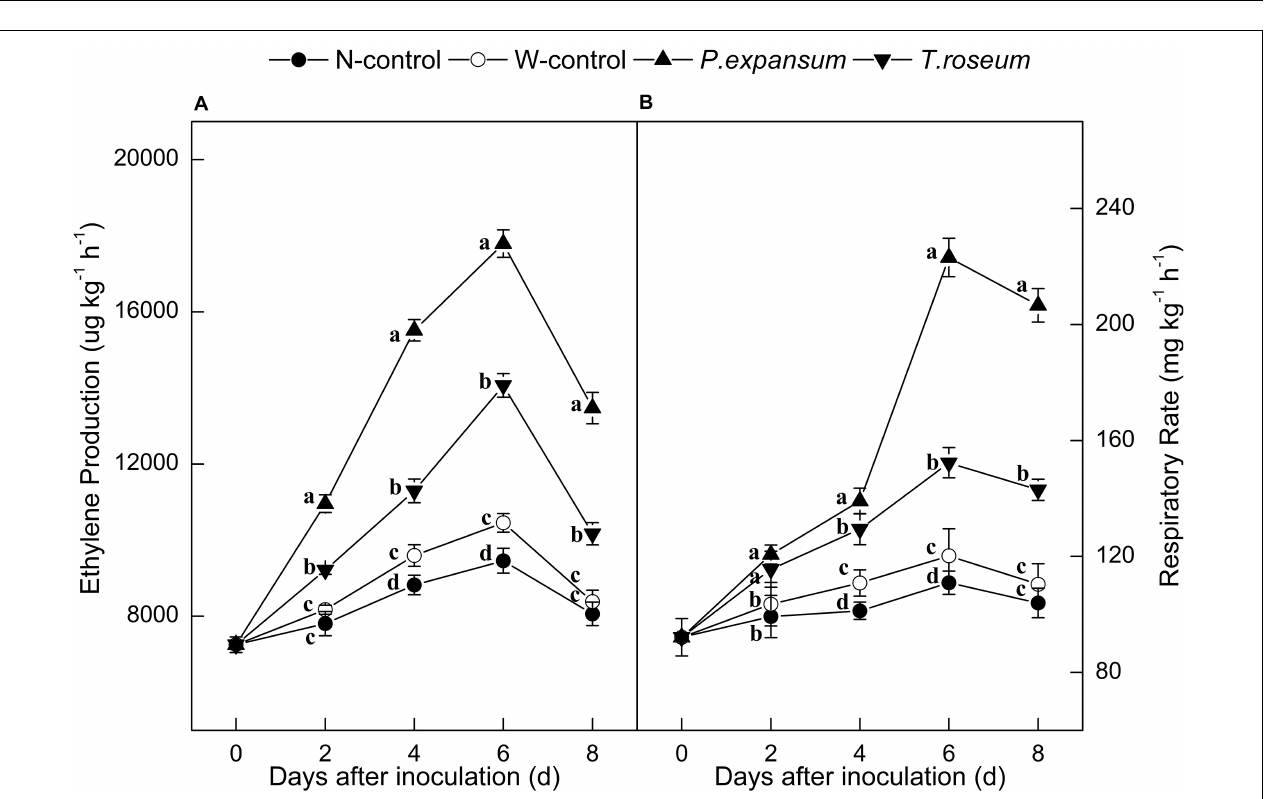
FIGURE 2 | Effects of P. expansum and T. roseum inoculation on ethylene production (A) and respiratory rate (B) of apple fruit during storage. All data are expressed as means ± standard deviation of triplicate samples. Different letters indicate significant differences ( P <